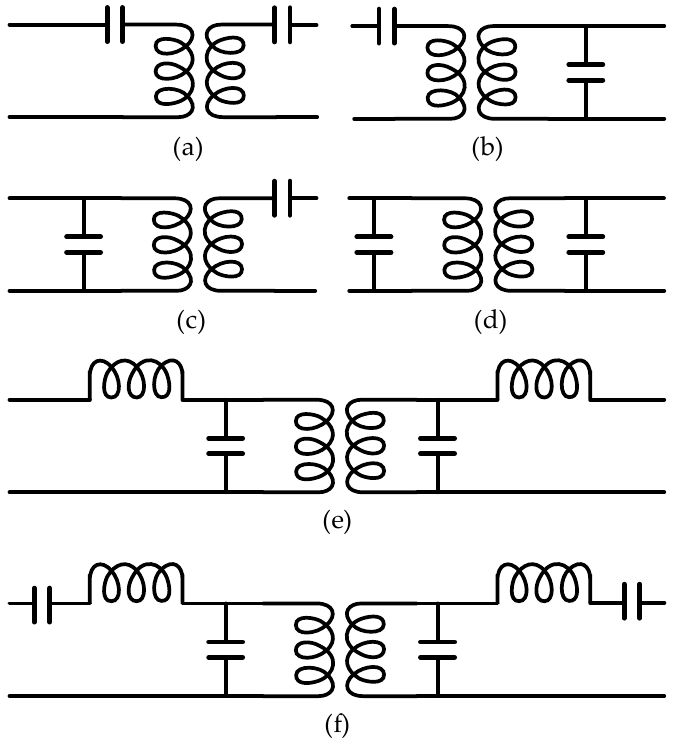
Figure 5. Compensation network topologies: ( a ) SS; ( b ) SP; ( c ) PS; ( d ) PP; ( e ) LCL; ( f ) CLCL [24].